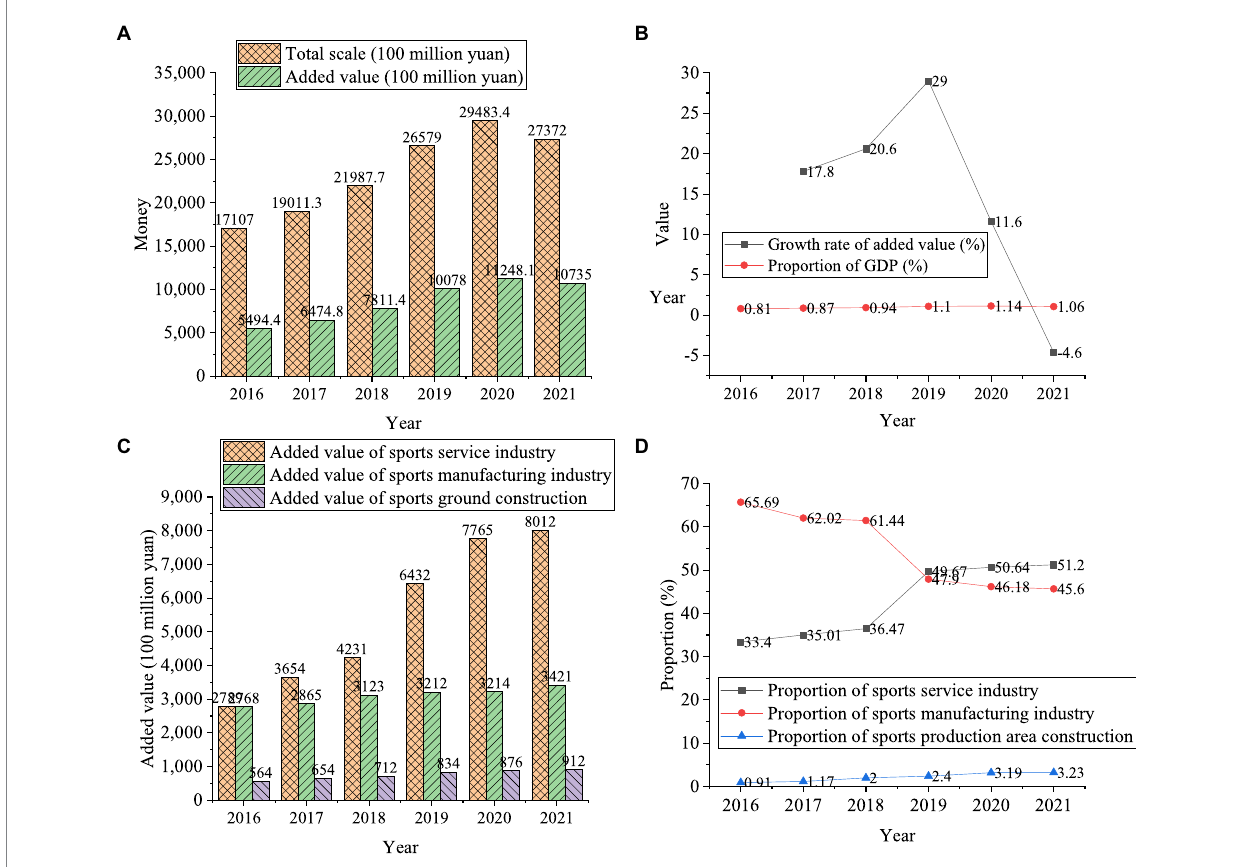
FIGURE 3 Statistics on the development of China’s sports industry (A) refers to the overall development of the sports industry, (B) is the overall growth rate of the sports industry, (C) illustrates the development of the sports industry in different directions, and (D) shows the proportion of development in different